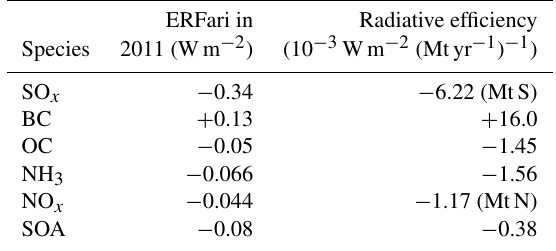
Table 5. Contribution to ERFari from each aerosol precursor species and contribution to 2011 ERFari. ERFari in Radiative